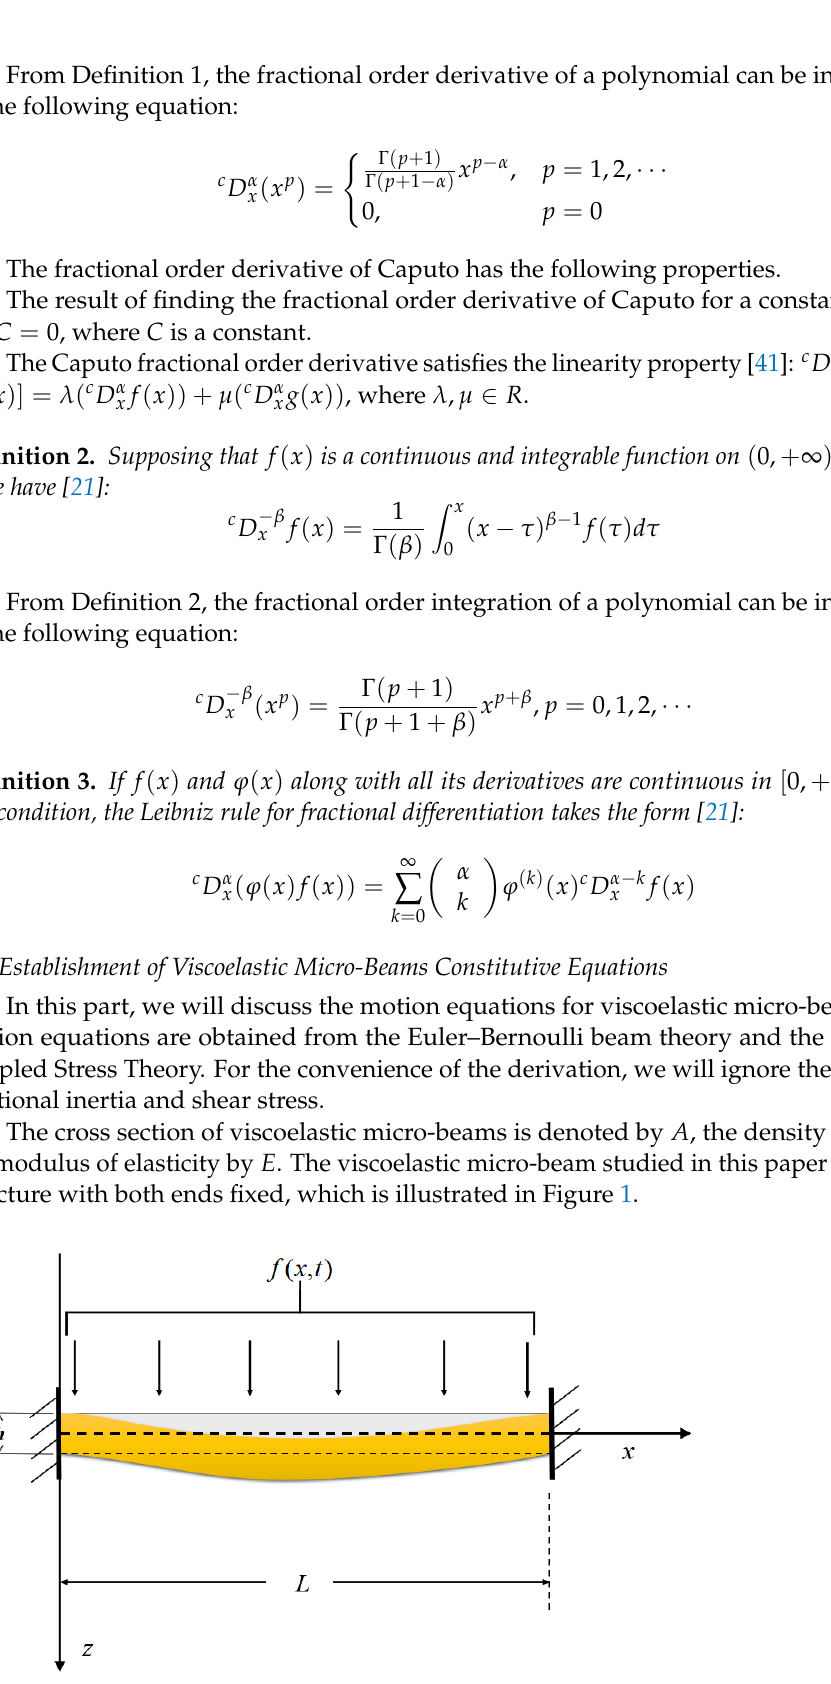
Figure 1. Bending deformation of viscoelastic micro-beams under simple harmonic load f ( x , t )